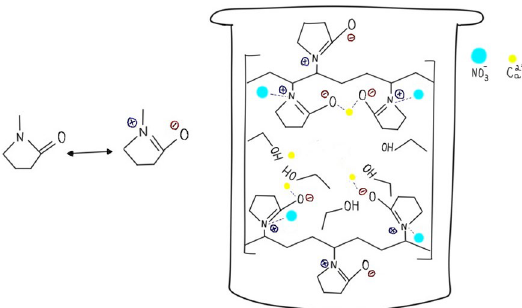
Figure 3. Mechanism of interactions between the PVP and the calcium nitrate ions.